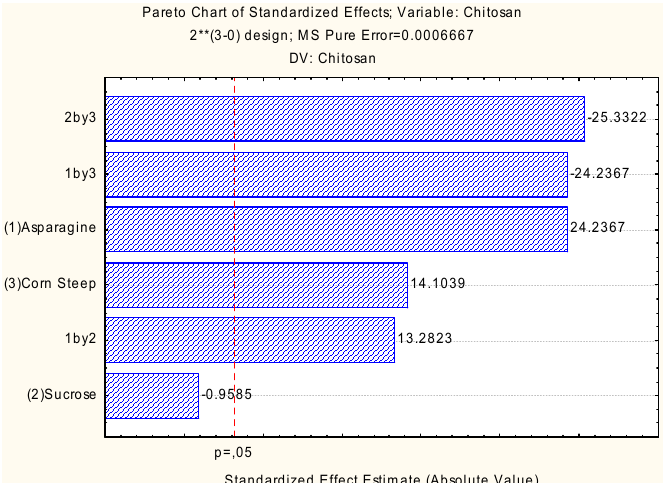
Figure 2. Pareto Chart of standardized effects for 2 3 full factorial design having as independent variables: (1) asparagine (2) sucrose and (4) corn steep concentrations and as the response variable the chitosan yield by Cunninghamella elegans related to carbon and nitrogen